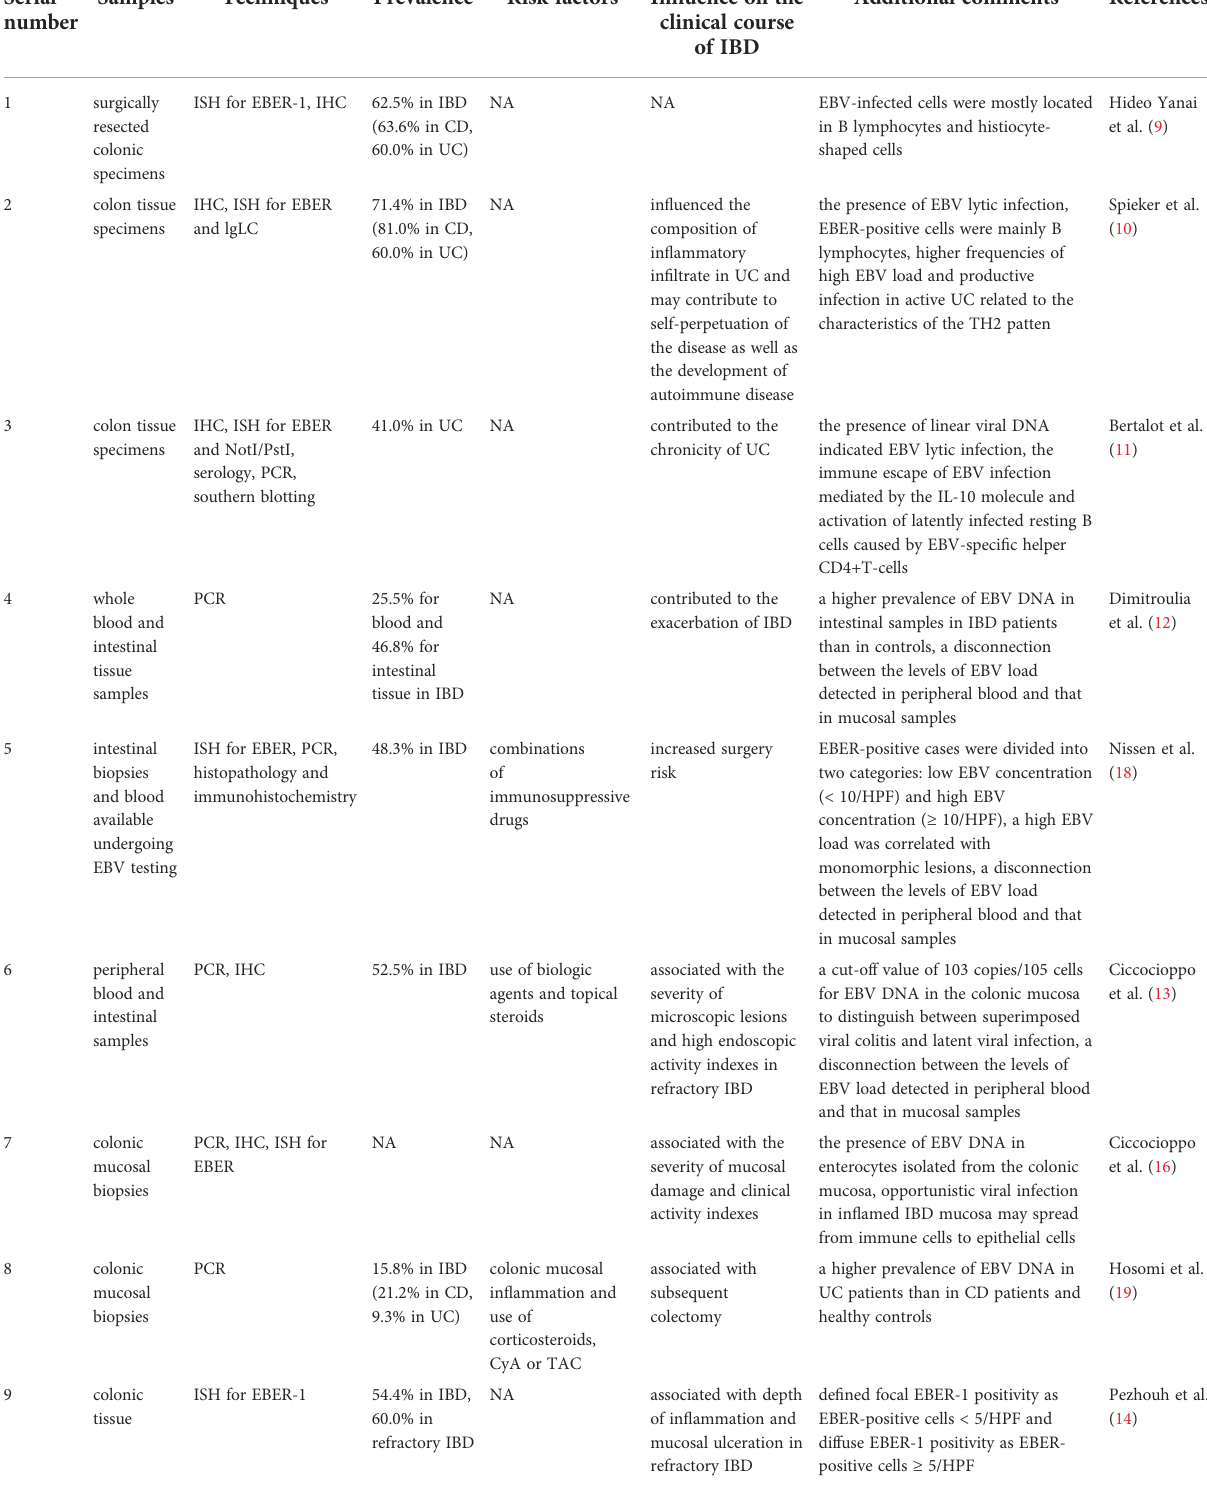
TABLE 1 Epstein – Barr virus-associated viral colitis in IBD patients and the in fl uence of EBV on the clinical course of